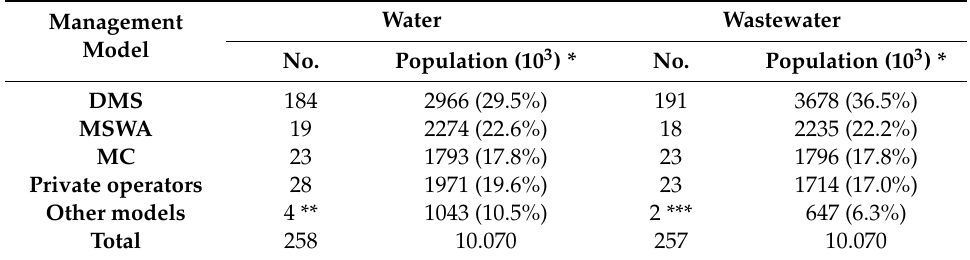
Table 1. Management models of the “retail” component of water and sanitation services.